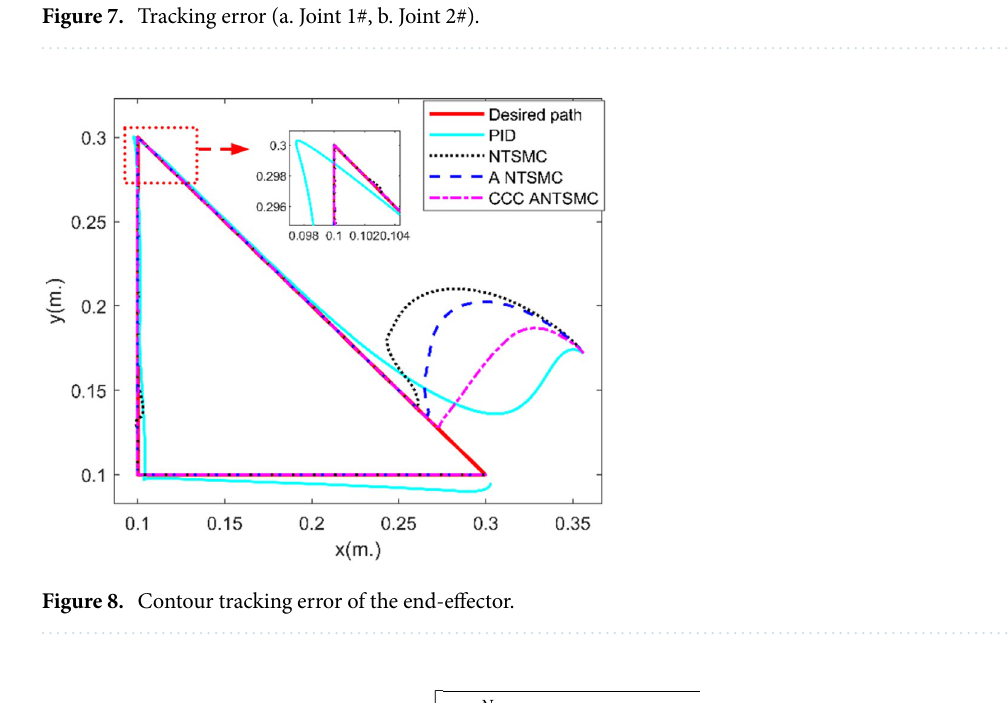
Figure 7. Tracking error (a. Joint 1#, b. Joint 2#).